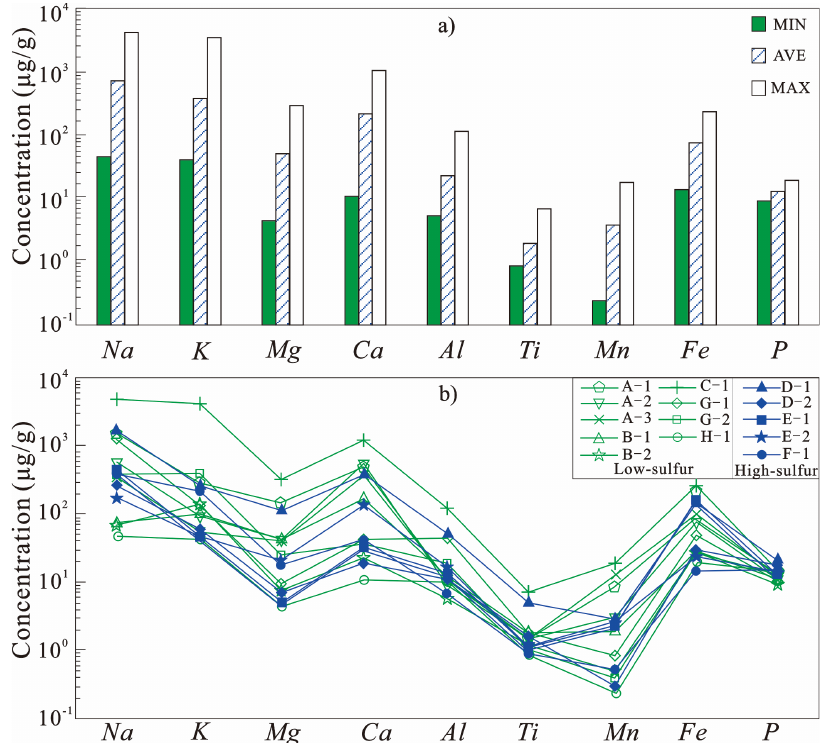
Figure 4. Concentrations ( a ) and distribution patterns ( b ) of major elements in the studied oil samples. Table 2. Concentrations of major and trace elements in the studied oil samples.